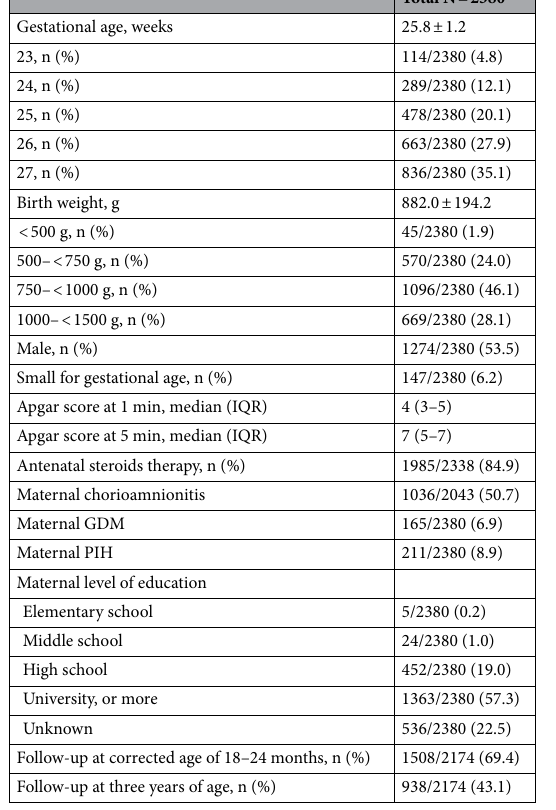
Table 1. Characteristics of the patients who were registered in the Korean Neonatal Network. Values are expressed as mean ± standard deviation or number (%). IQR, interquartile range; GDM, gestational diabetes mellitus; PIH, pregnancy induced